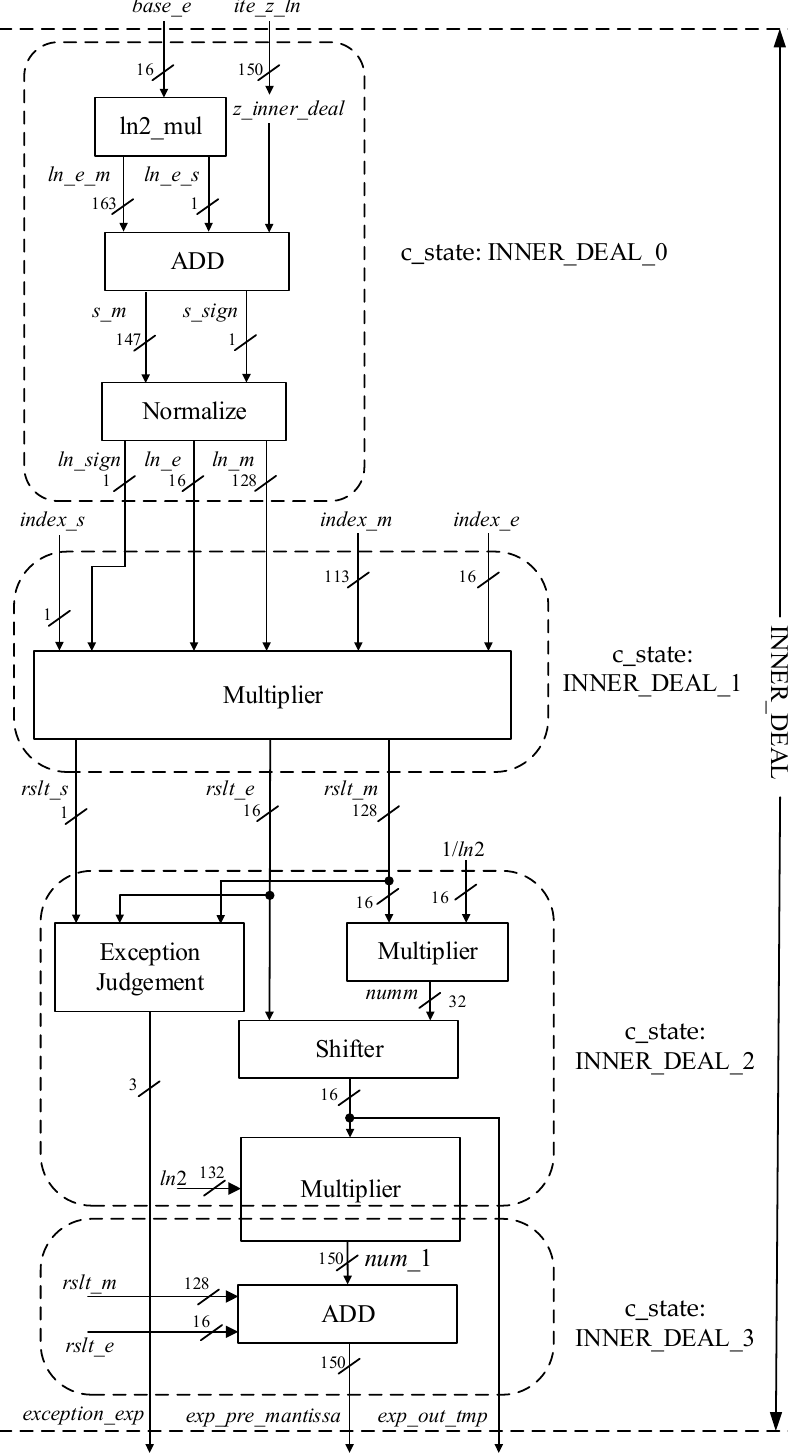
Figure 6. Architecture of states INNER_DEAL_0, INNER_DEAL_1, INNER_DEAL_2, and IN- NER_DEAL_3.